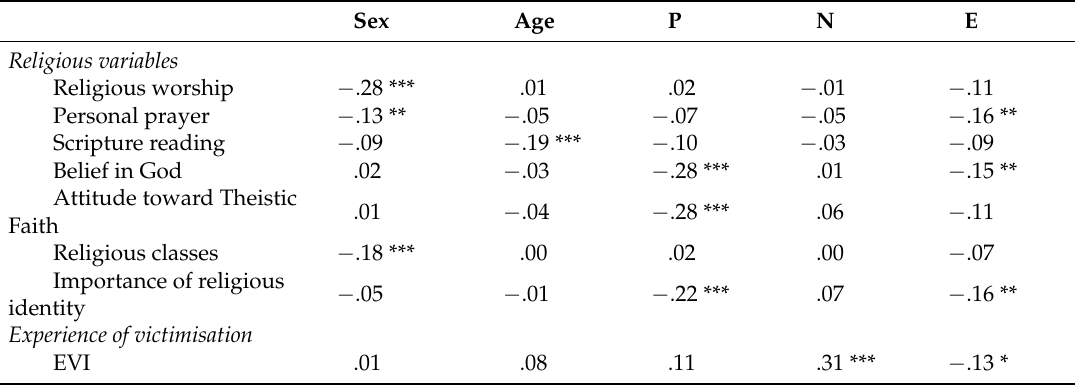
Table 3. Correlations with personal and psychological